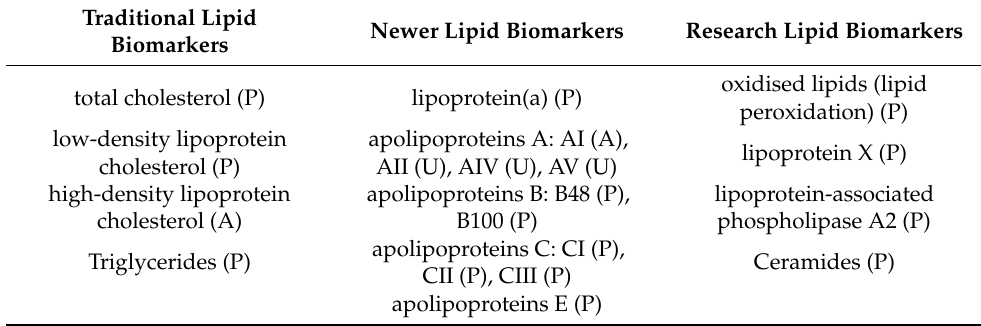
Table 2. Traditional, newer and research lipid biomarkers; (P)—pro-atherogenic, (A)—anti- atherogenic, (U)—atherogenic function less clear/mixed results. Traditional Lipid Newer Lipid Biomarkers Research Lipid Biomarkers Biomarkers oxidised lipids (lipid total cholesterol (P) lipoprotein(a) (P) peroxidation) (P) low-density lipoprotein apolipoproteins A: AI (A), lipoprotein X (P) cholesterol (P) AII (U), AIV (U), AV (U) high-density lipoprotein apolipoproteins B: B48 (P), lipoprotein-associated cholesterol (A) B100 (P) phospholipase A2 (P) apolipoproteins C: CI (P), Triglycerides (P) Ceramides (P) CII (P), CIII (P) apolipoproteins E